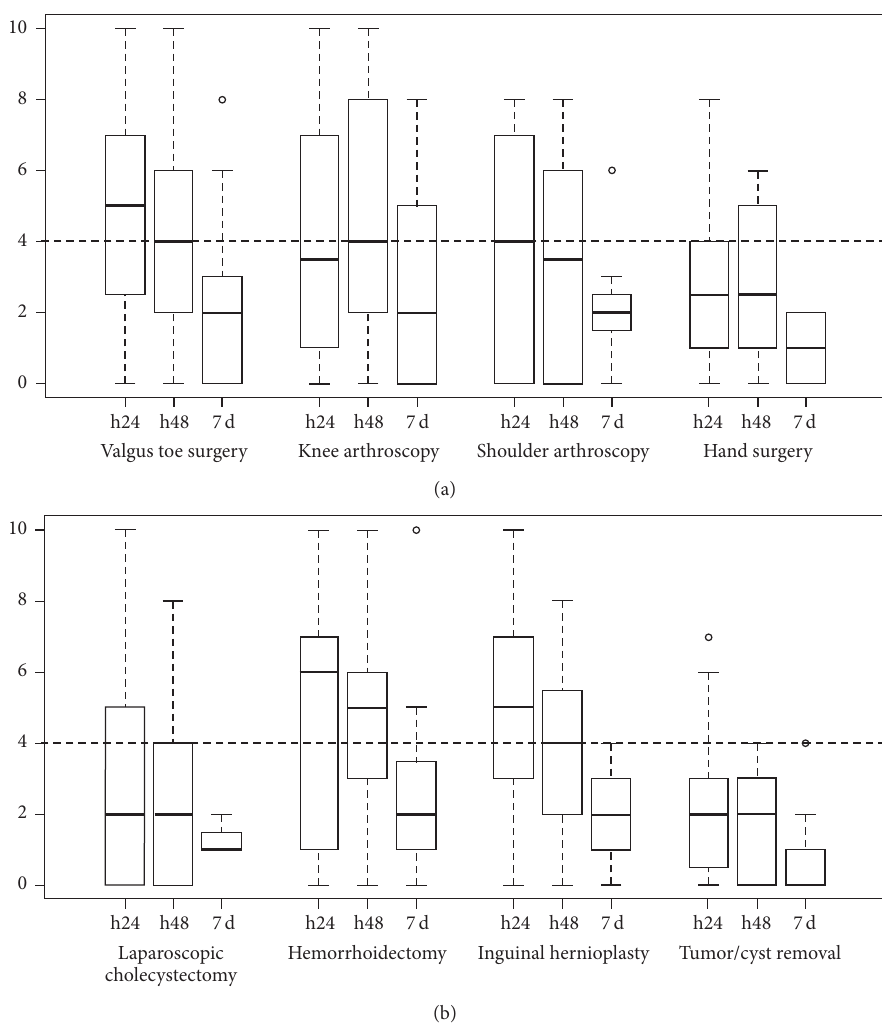
Figure 1: Box plot of pain scores for orthopedic (a) and general (b)